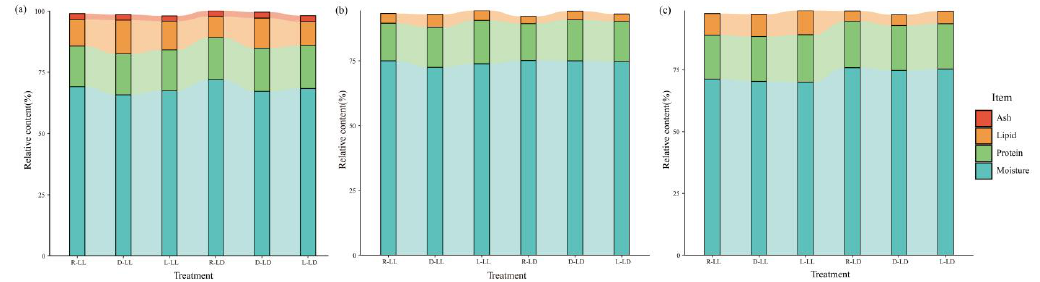
Figure 1. The body composition of juvenile Oncorhynchus mykiss under different experimental treatment. ( a ) Whole fish. ( b ) Liver. ( c ) Dorsal muscle.